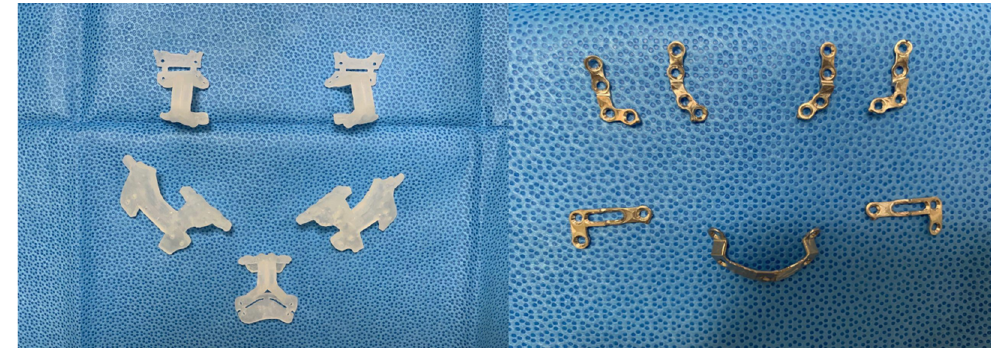
Figure 3. Actual 3D-printed cutting guides ( left ) and miniplates ( right ). The predicted drilling holes are placed on the guides with the osteotomy line marked. The plate printed according to the bony contour does not require bending.